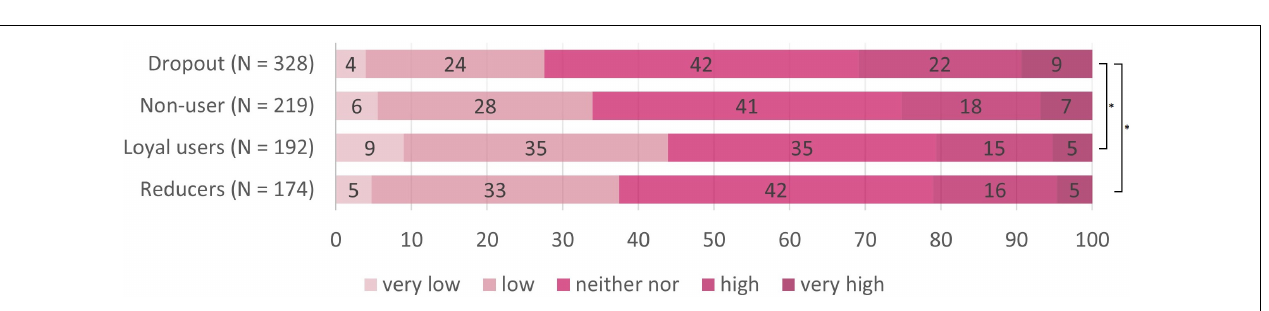
FIGURE 7 | Subjective risk perception for using the cab in the different target groups. N = 918; numbers on the bars represent percentages. * p < 0.008 in the pairwise